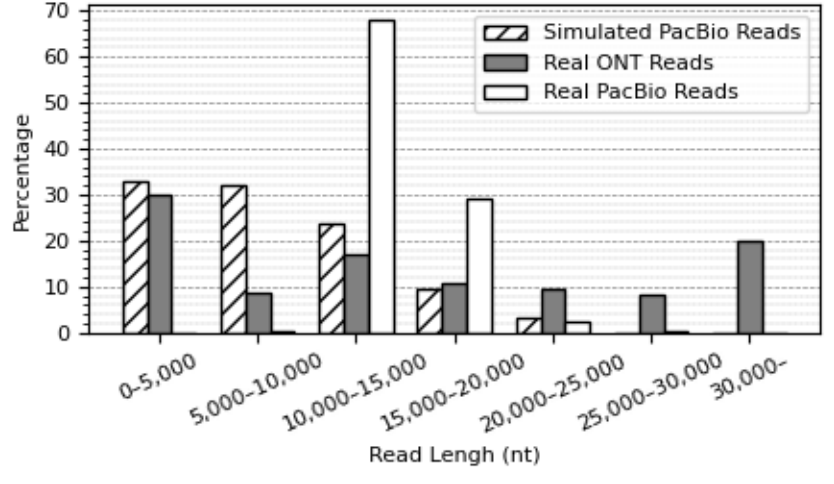
Figure 3. Simulated, real ONT, and real PacBio read length percentage histograms. Read lengths are grouped in intervals of 5000 nucleotide bases, except for the rightmost column, which represents all reads longer than 30,000